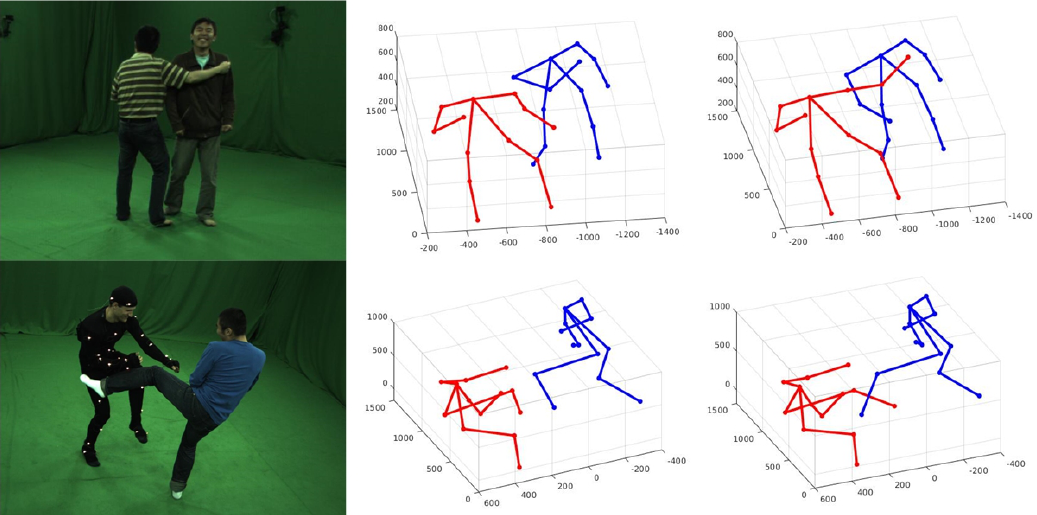
Figure 5. Comparison results for 3D pose detection without ( Middle ) and with ( Right ) symmetry parts gray term